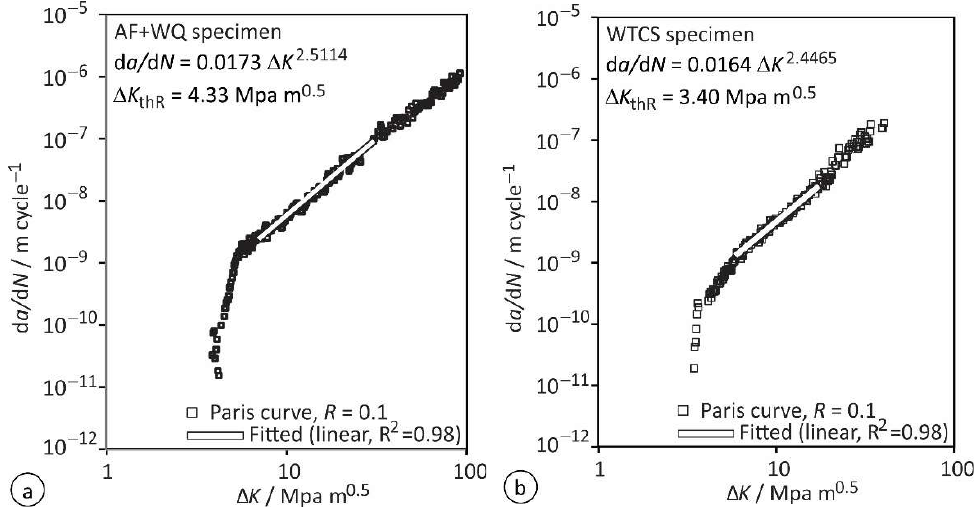
Figure 8. Results of the fatigue crack growth test: ( a ) AF + WQ specimen; ( b ) WTCS specimen. Table 6. Results of the fatigue crack growth tests. R / − ∆ K thR /MPa m